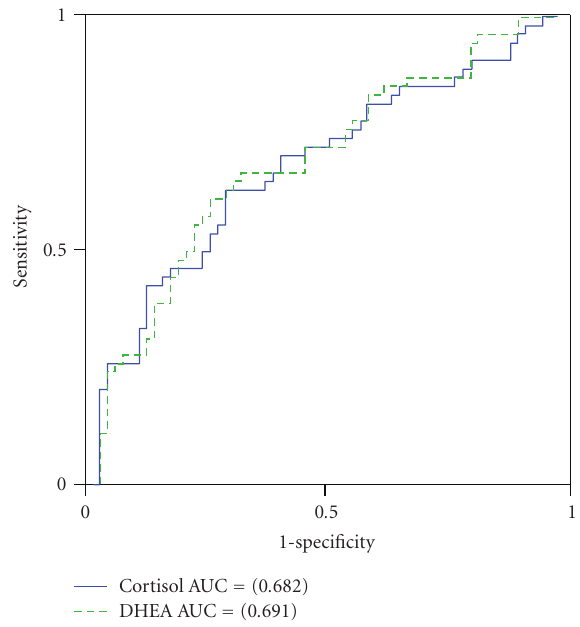
Figure 1: ROC curves used for the cuto ff values of cortisol (ng/mL) and DHEA (pg/mL) in saliva to screen PD levels in never-smokers.